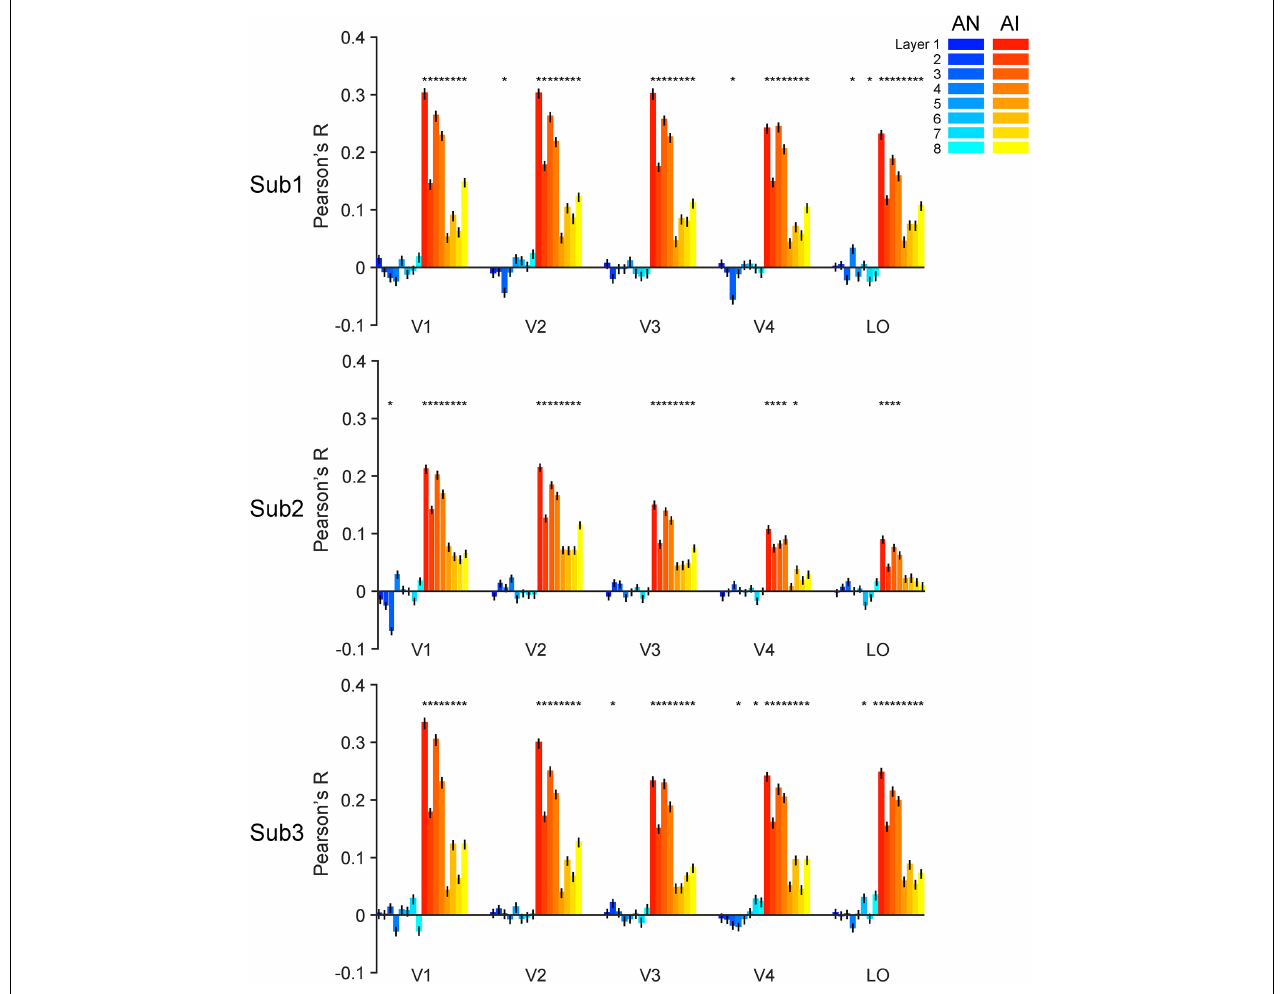
FIGURE 6 | Accuracy of forward encoding models trained on RE images and then tested on adversarial images. After the models are fully trained on the RE images, we input the adversarial images as inputs to the models can predict corresponding brain responses. The y -axis indicates the Pearson correlation between the brain responses predicted by the models and the real brain responses. The generalizability of forward encoding models indicates the processing similarity between the RE and AN (cool colors) or AI (warm colors) images. Error bars indicate 95% bootstrapped confidence intervals (see